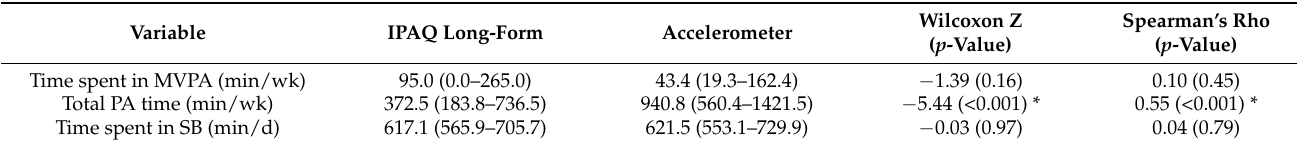
Table 3. Comparison and correlation analysis of physical activity and sedentary behavior data as measured by the IPAQ long-form and the